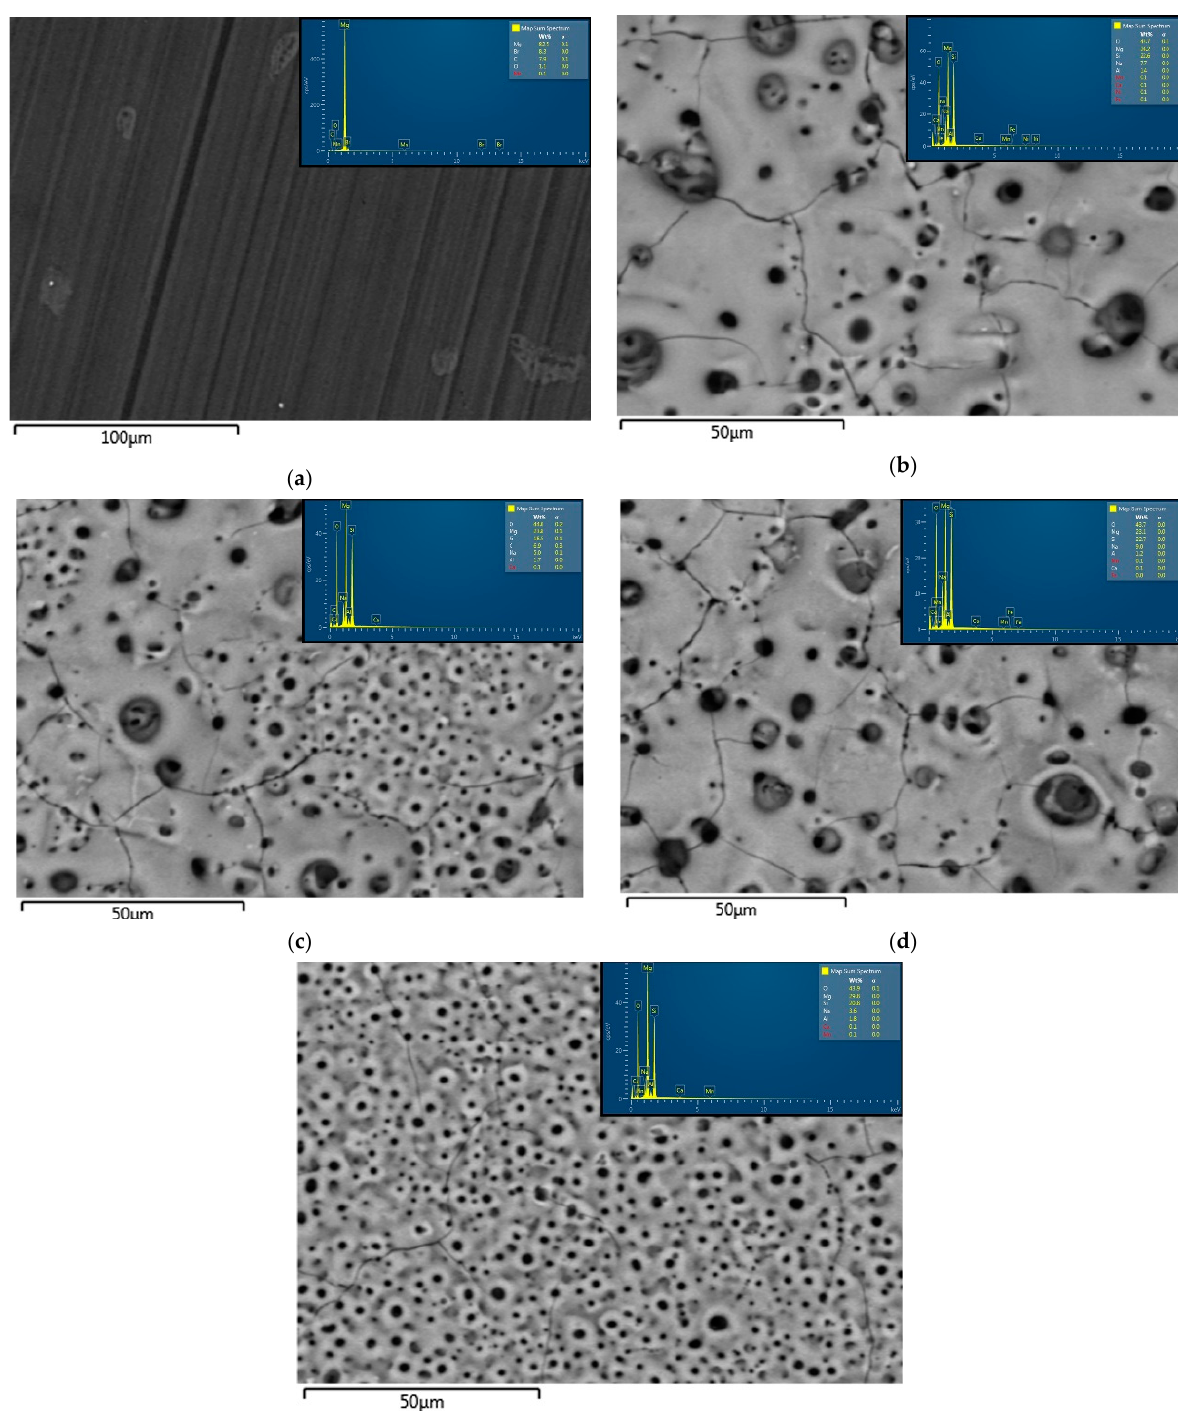
Figure 3. EDS analysis of the AM60 before and after coating at different conditions: ( a ) BM, ( b ) UP, ( c ) BP30, ( d ) BP50 and ( e ) BP66.